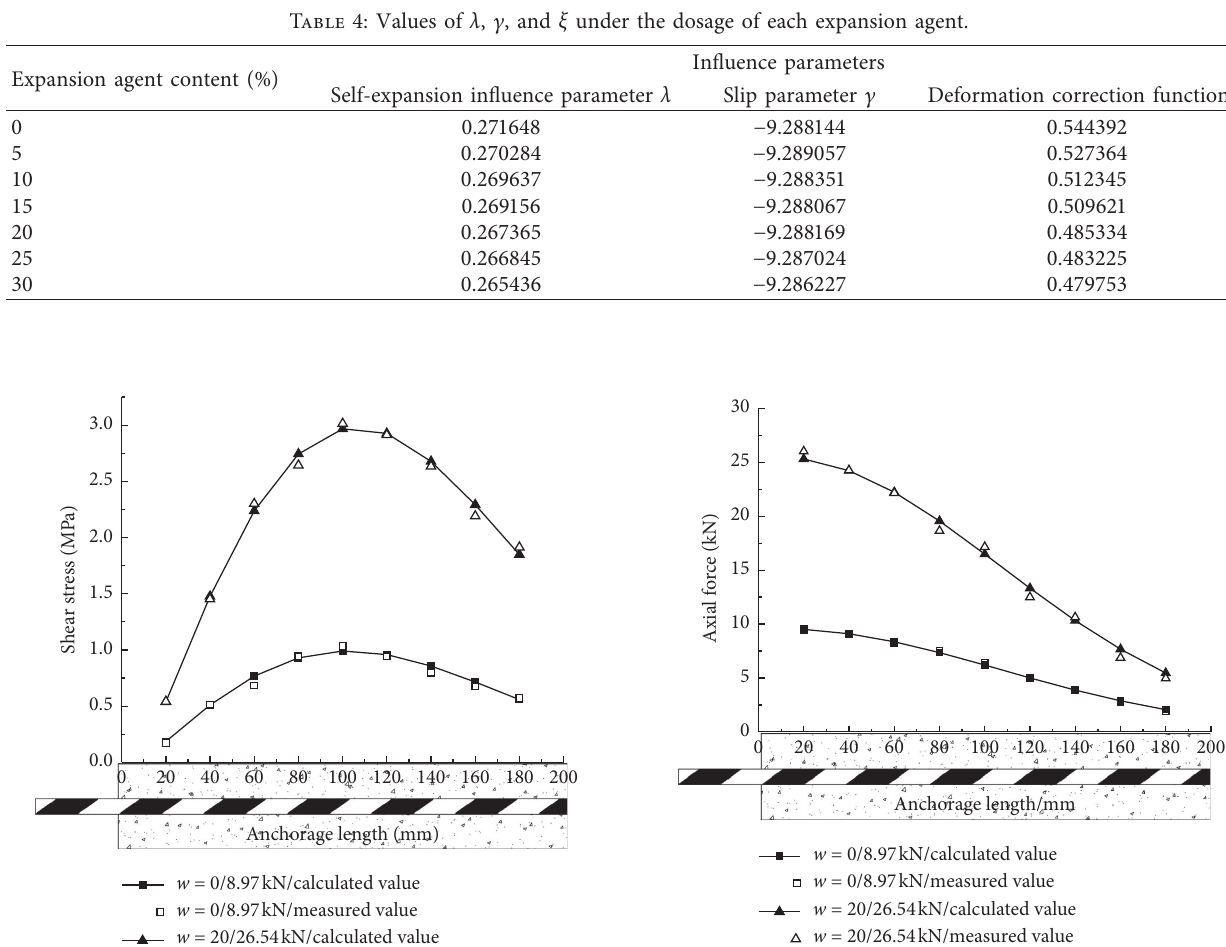
Figure 22: Comparison of measured and calculated axial